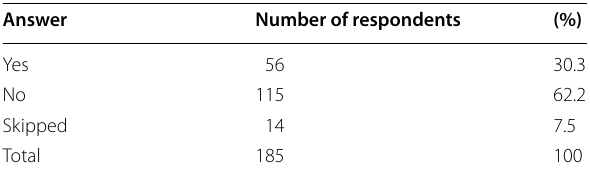
Table 8 Experience of 185 respondents with AI-based algorithms for clinical diagnostic interpretive tasks: Was the diagnostic accuracy (ROC curves) supervised on a regular basis in comparison with the final diagnosis in the medical record?